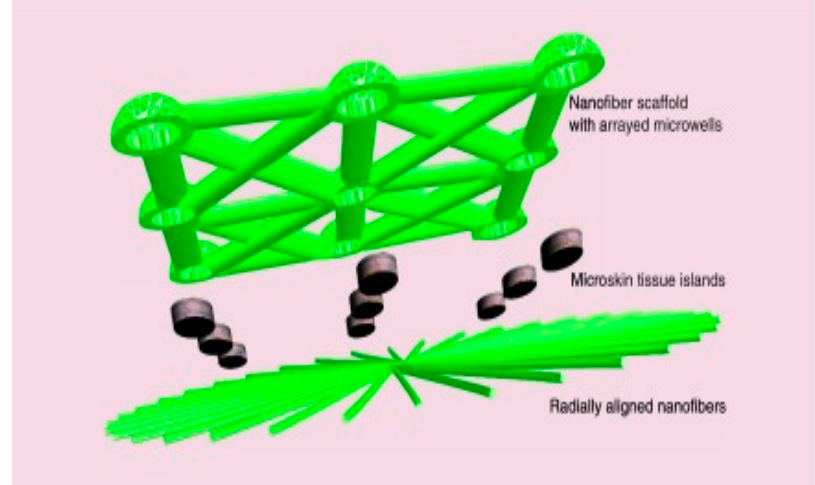
Figure 5. Sandwich-type NF skin grafts. Reprinted with permission from ref. [104].